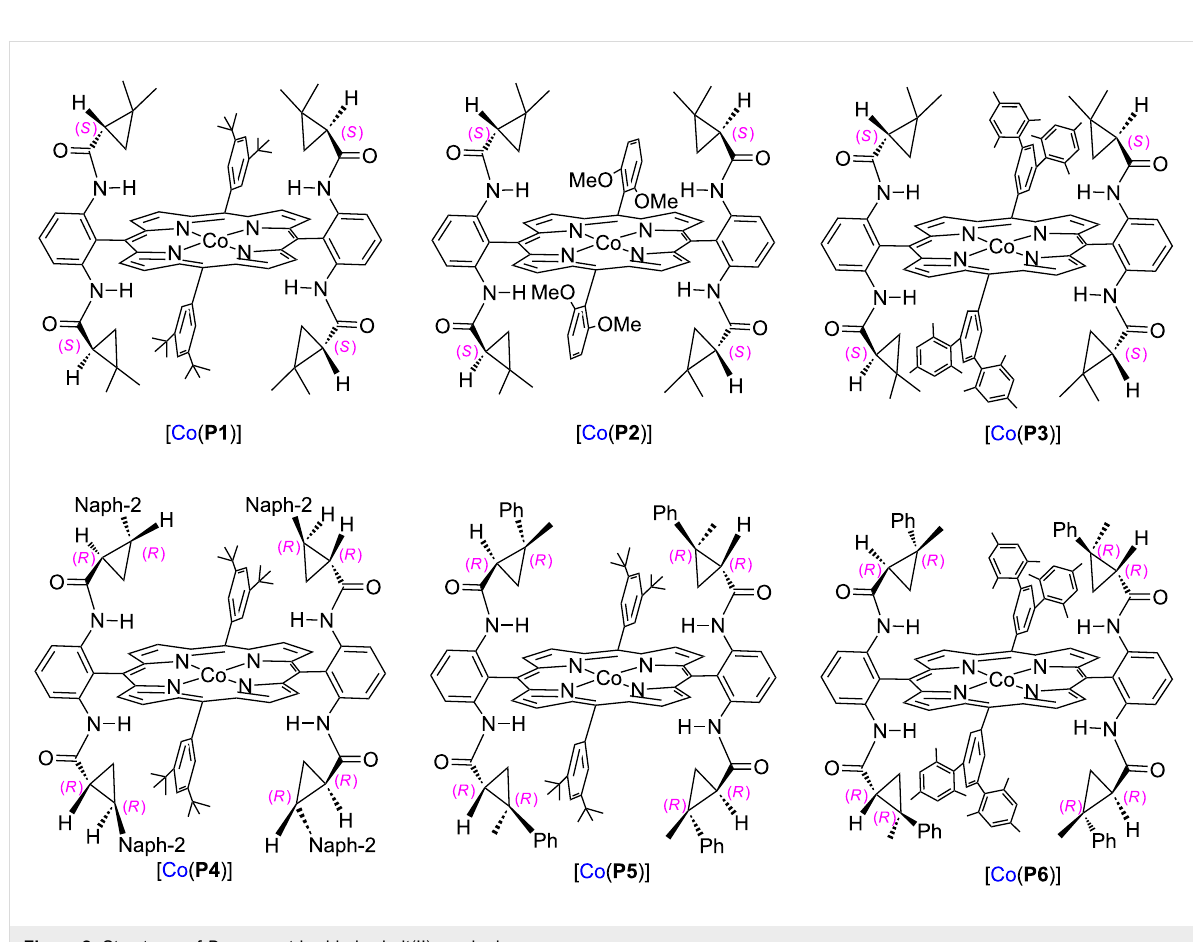
Figure 2: Structures of D 2 -symmetric chiral cobalt(II)